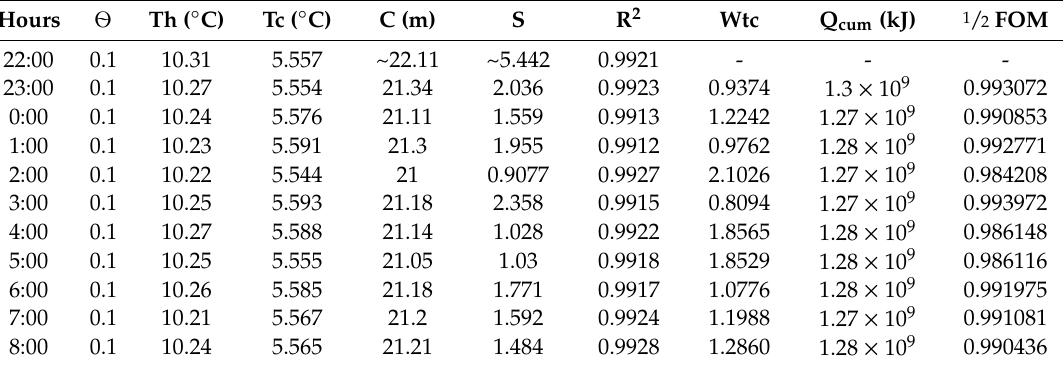
Table 1. 1st–2nd January 2019 Curve Fitting and Performance Parameter analysis.